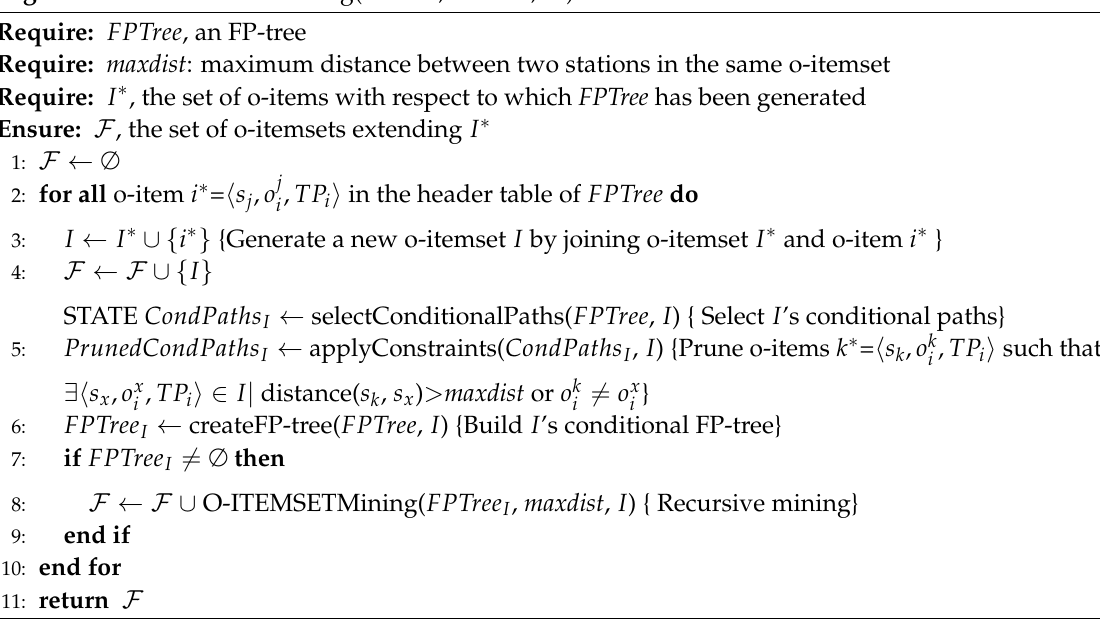
Algorithm 2 O-ITEMSETMining( FPTree , maxdist , I ∗